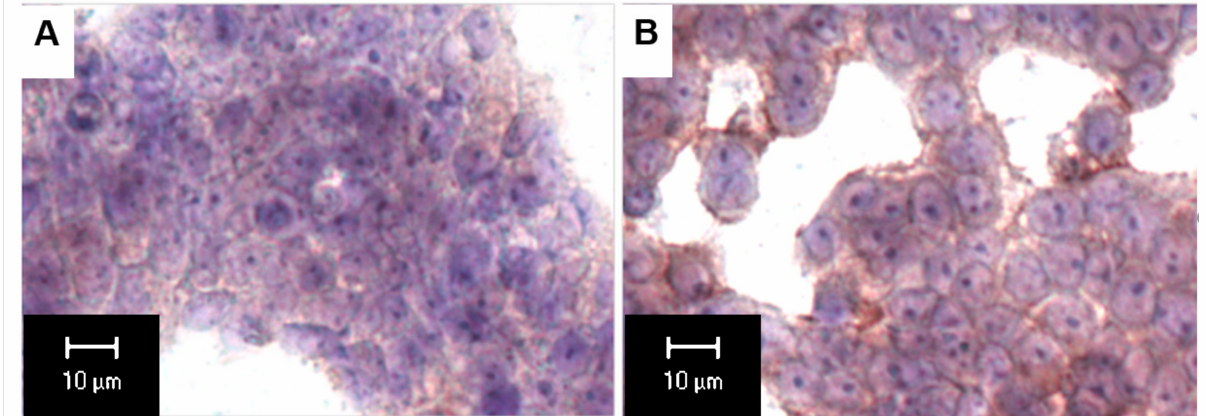
Figure 2. ARSB immunostaining of malignant and non-malignant human colonic epithelial cell lines. The malignant T84 cells ( A ) have markedly lower immunohistochemical intensity than the NCM460